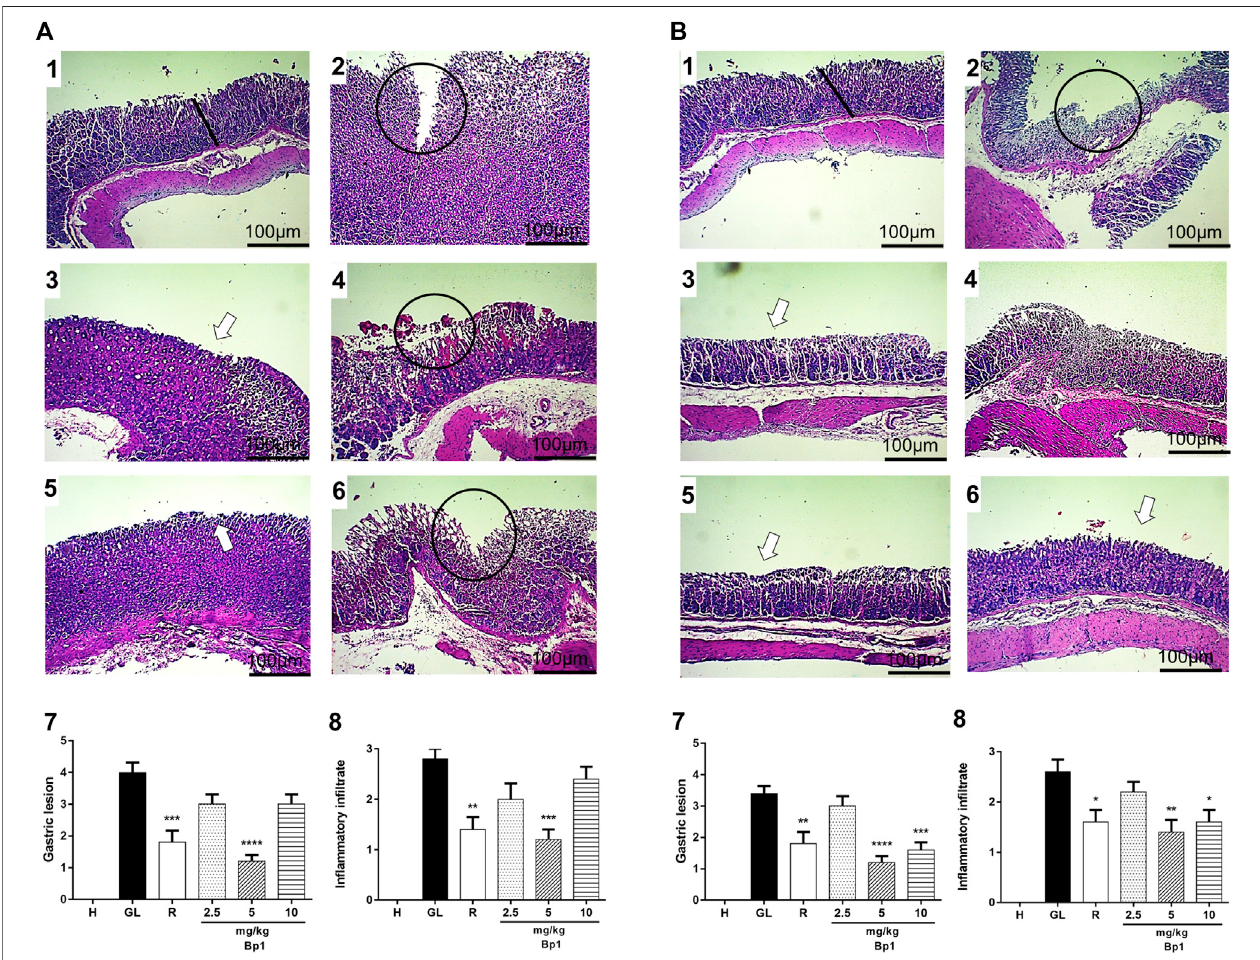
FIGURE15| Effectofpre-treatmentwithBp1(2.5,5,and10 mg/kg)onthehistologyofethanol-induced (A) andindomethacin-induced (B) gastricmucosallesions in mice. Histopathological characteristics of the gastric tissue of rats, showing the cut of the stomach in the transverse direction. (A) Ethanol-induced: (1) Healthy; (2) Gastric lesion control; (3) Ranitidine, 50 mg/kg; (4) Bp1 2.5 mg/kg; (5) Bp1 5 mg/kg; (6) Bp1 10 mg/kg; (7) Gastric lesion score; (8) In fl ammatory in fi ltrate score. (B) Indomethacin-induced: (1) Healthy; (2) Gastric lesion control; (3) Ranitidine, 50 mg/kg; (4) Bp1 2.5 mg/kg; (5) Bp1 5 mg/kg; (6) Bp1 10 mg/kg; (7) Gastric lesion score; (8) In fl ammatory in fi ltrate. The bar indicates gastric mucosa without changes; Circle: severe lesion with distraction of the surface epithelium; White arrow: recovered mucosa. Results expressed as mean ± standard mean error ( n (cid:2) 7). Mann – Whitney used to calculate statistical signi fi cance, * p < 0.05, ** p < 0.01, *** p < 0.001, and **** p < 0.0001 vs. gastric lesion control. Healthy, H; Gastric lesion control, GL; Ranitidine (50 mg/kg), R. gastric mucosal damage in